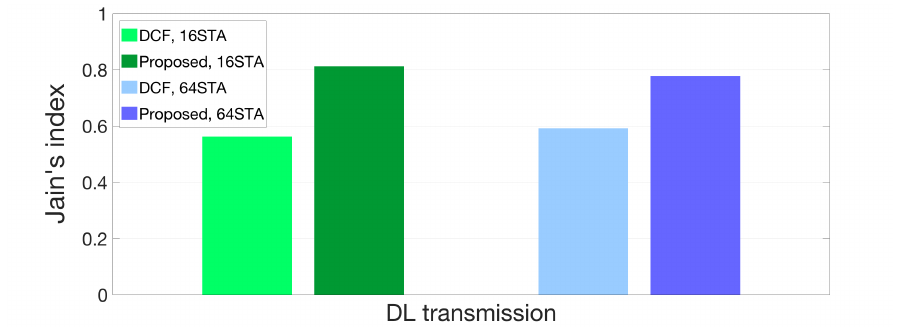
Figure 11. Fairness comparison between DCF and proposed protocol in DL scenario.